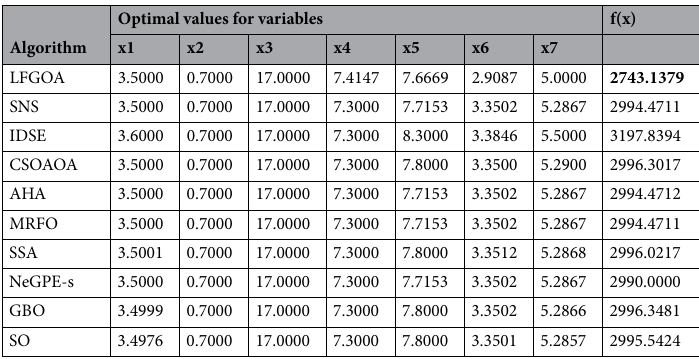
Table 25. Results of LFGOA and competitive algorithms in solving the speed reducer design. The best of the comparison results are in [bold].